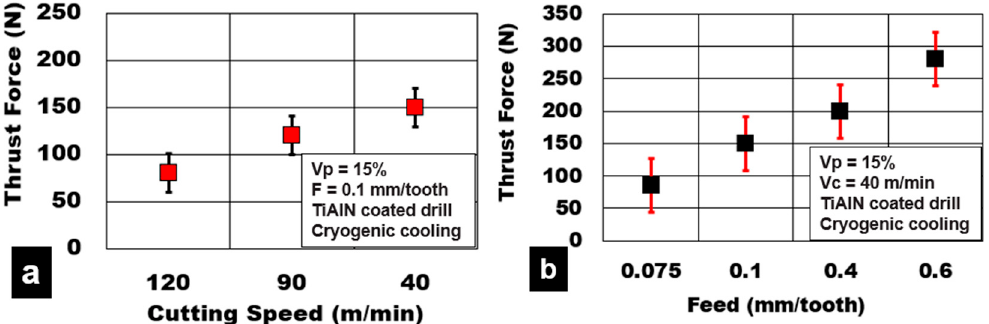
Figure 3. Effect of process parameters during plunge drilling of AZ31-alumina syntactic foam ( a ). effect of cutting speed; ( b ). effect of feed.